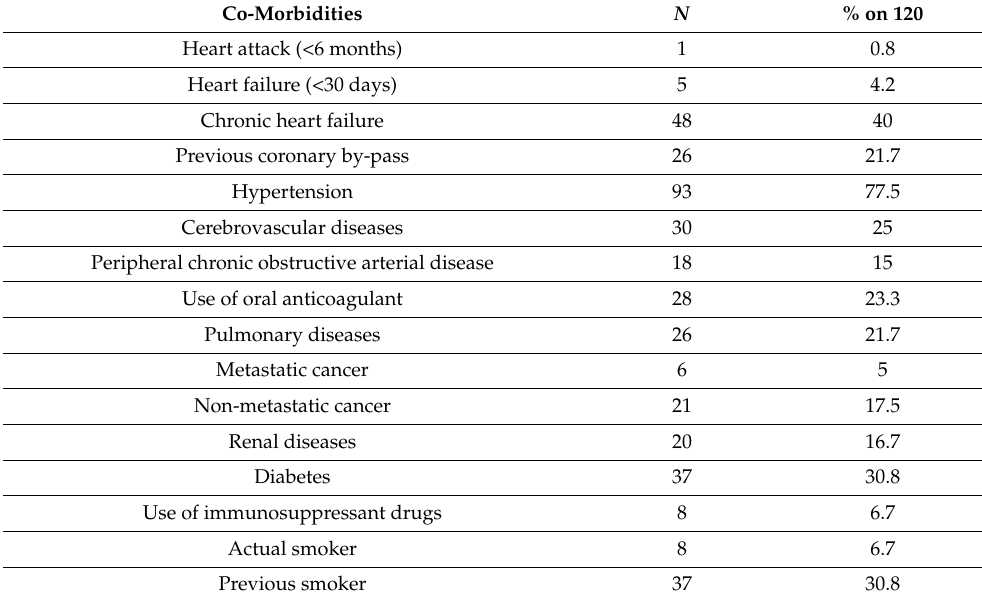
Table 1. Comorbidities.